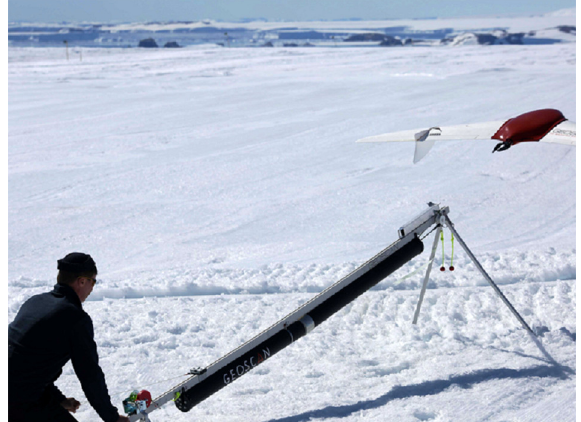
Figure 2. The Geoscan 201 Geodesy launching by a catapult